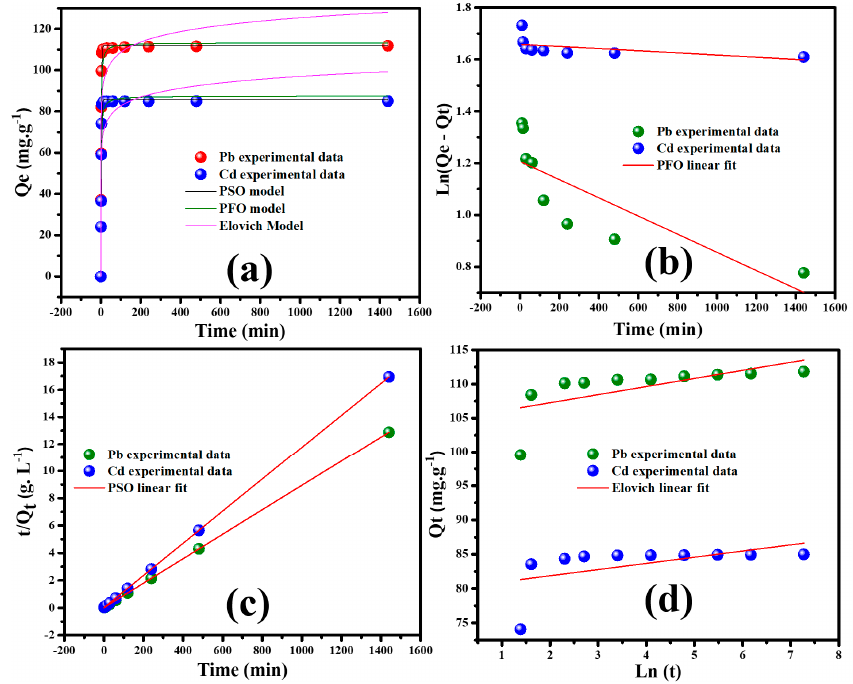
Figure 7. ( a ) Effect of contact time, linear fit of ( b ) pseudo–first order, ( c ) pseudo–second order, and ( d ) Elovich on the sorption of Pb ++ /Cd ++ onto MGCN sorbent. The presence of active metal sites and facile accessibility without obstacles mainly Table 1. Kinetics models for the adsorption of Pb ++ /Cd ++ by MGCN sorbent.